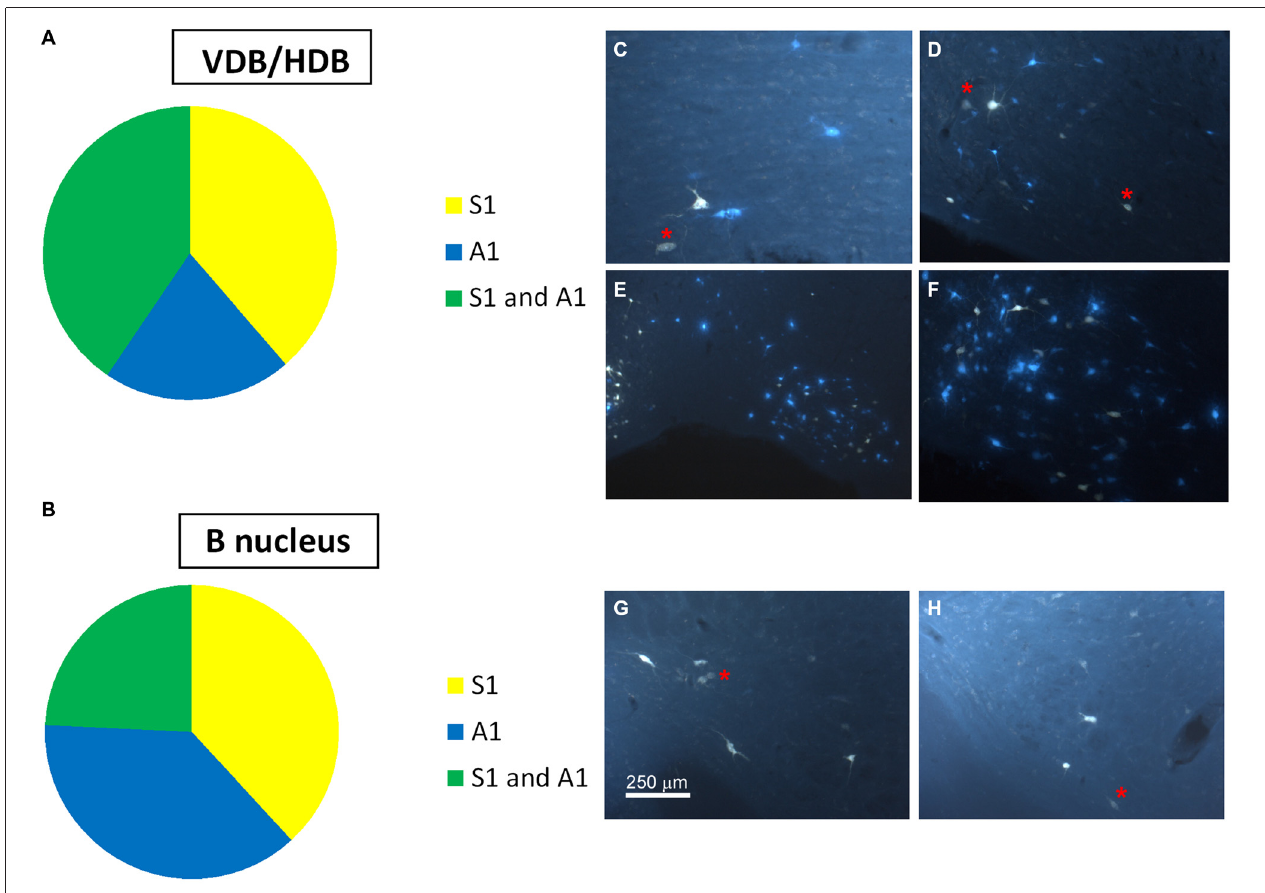
FIGURE 4 | Distribution of labeled neurons in the VDB/HDB and B nuclei. (A) Graphic representation of number of labeled neurons in the VDB/HDB after deposit in the S1 and A1 cortices. Note that this BF area mainly project to the S1 cortex. (B) Graphic representation of the number of labeled neurons in the B nucleus after deposits in the S1 and A1 cortices. Note that this BF area project to the S1 and A1 cortices in a similar proportion. (C–F) Samples of fluorescent microscope images of single- and double-labeled neurons in HDB. (G,H) Samples of fluorescent microscope images of single- and double-labeled neurons in SI/B nucleus. Red asterisks indicate double-labeled neurons. Calibration toolbars (C,D,F–H) 230 µ m, (E) 530 µ m.